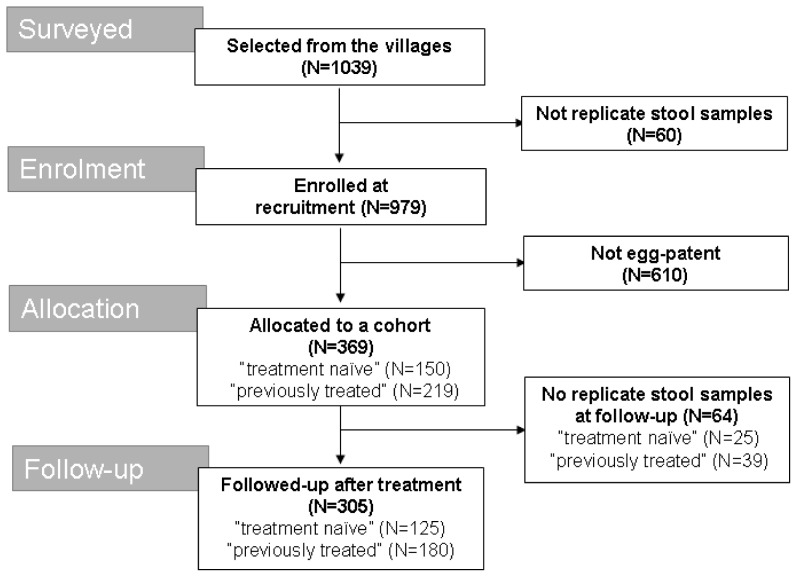
Number of volunteers upon enrolment and sample submission compliance pre- and post-intervention surveys.No. of children upon follow-up by age: 2 children aged 5–12 months, 23 children aged 13–24 months, 39 children aged 25–36 months, 45 children aged 37–48 months, 83 children aged 49–60 months, 66 children aged 61–72 months and 35 children aged 73–84 months (missing age information for 12 children).